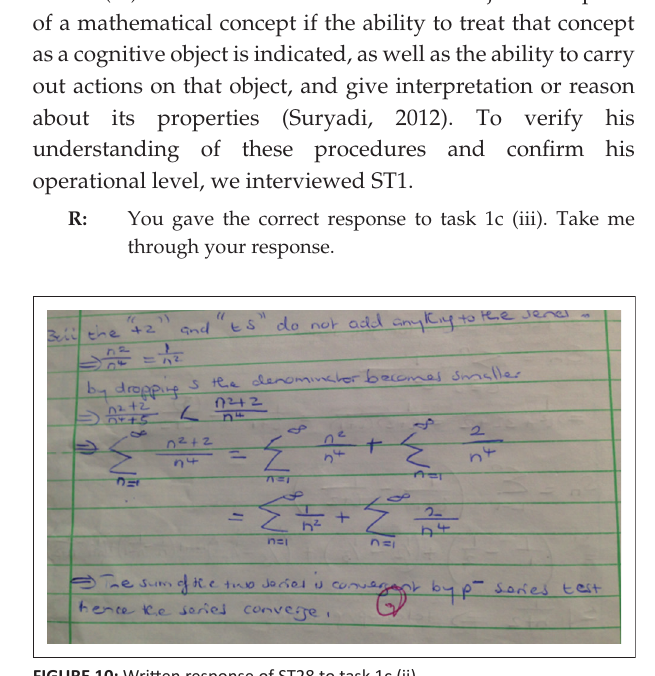
FIG URE 10: Written response of ST28 to task 1c (ii).